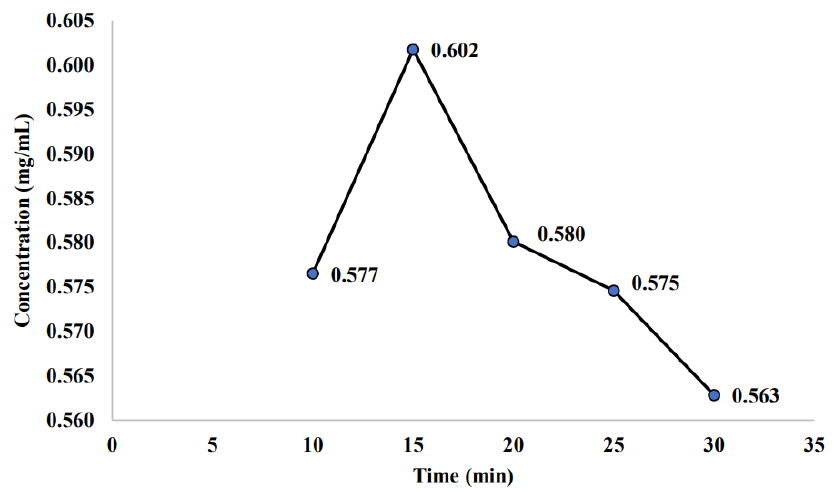
Figure 2. Saponin concentration of initial PFC sample at different concentration times.